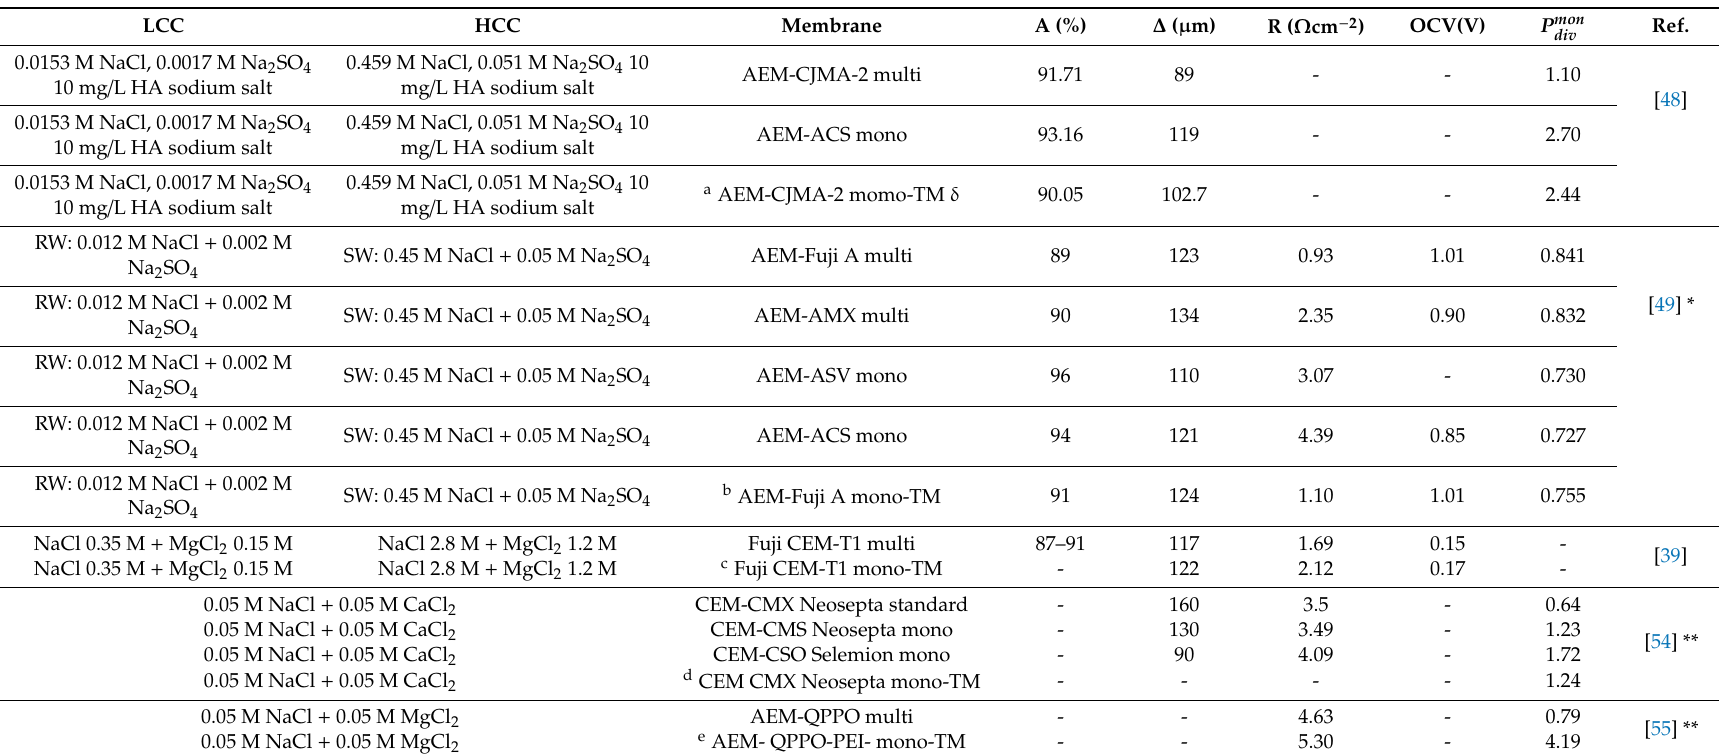
Table 2. Comparison of the impact of monovalent ion selective membrane on the performance of ED and